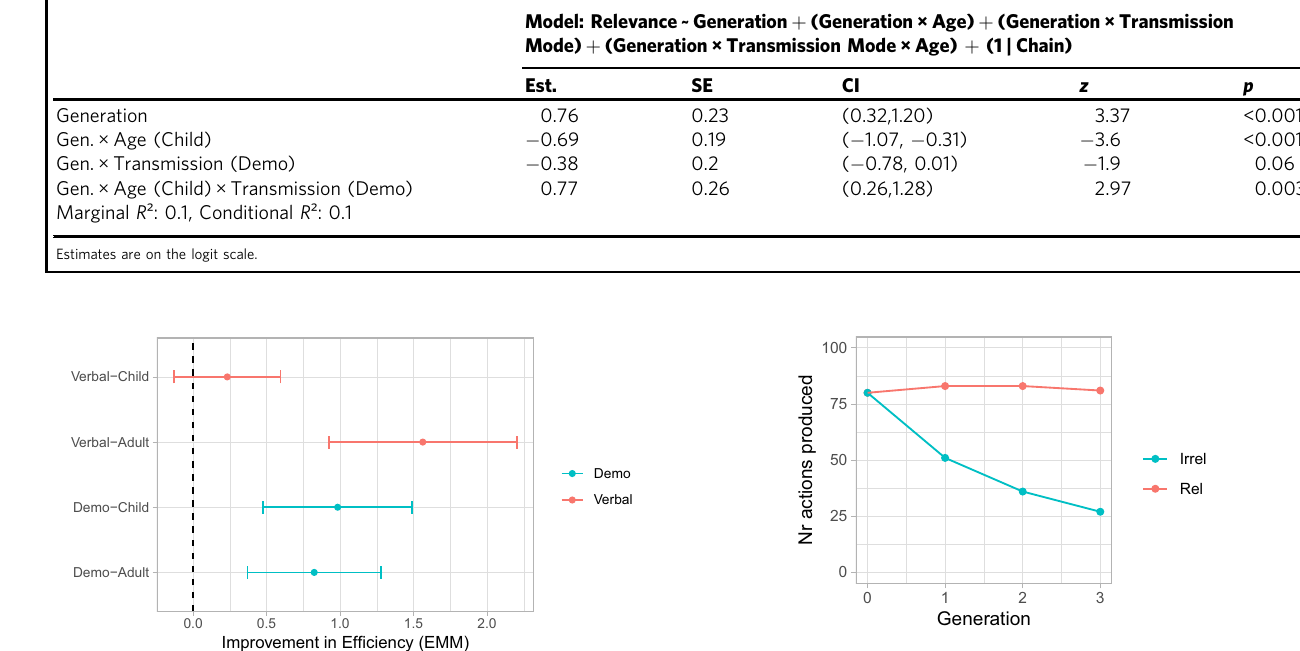
Fig. 7 Counts of causally Relevant and Irrelevant actions produced at each Generation illustrating a speci fi c decrease of Irrelevant actions. The speci fi c decrease of Irrelevant actions (Improvement in Ef fi ciency) is shown.